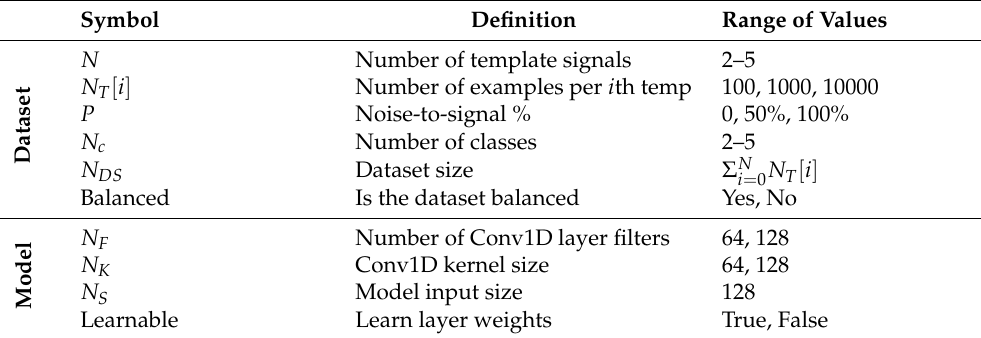
Table 2. The dataset and model parameters used in this set of